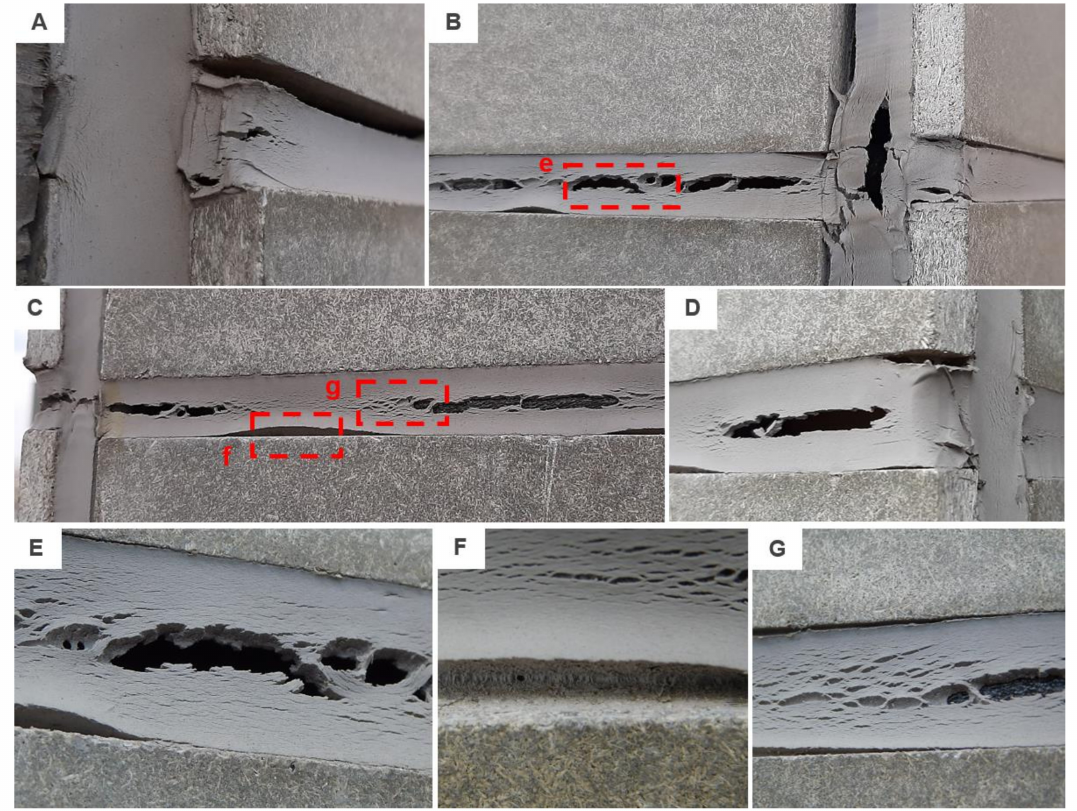
Figure 9. Examples of failure modes monitored after 4 years: ( A ) adhesive failure to the substrate in combination with crazing; ( B ) south-east façade and ( C ) north-west façade with cohesive failure caused by hardening as well as softening of the sealant; ( D )–( G ) details of observed